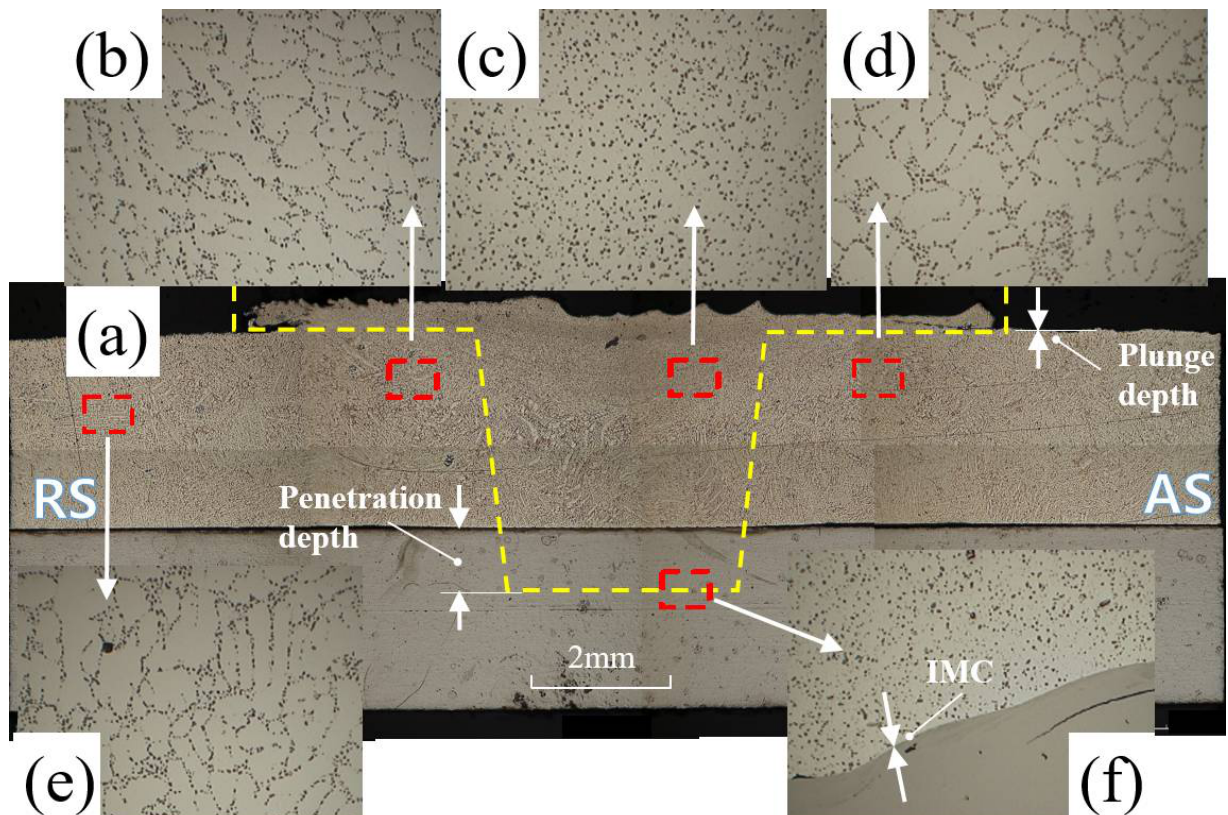
Figure 3. Optical micrographs of the FSW A357 cast alloy and FB590 HSS. ( a ) Overall cross-sectional macrostructure; ( b ) microstructure of the SZ; ( c ) microstructure of the TMAZ; ( d ) microstructure of the HAZ; ( e ) microstructure of the IMC; and ( f ) microstructure of the Al base metal [16].